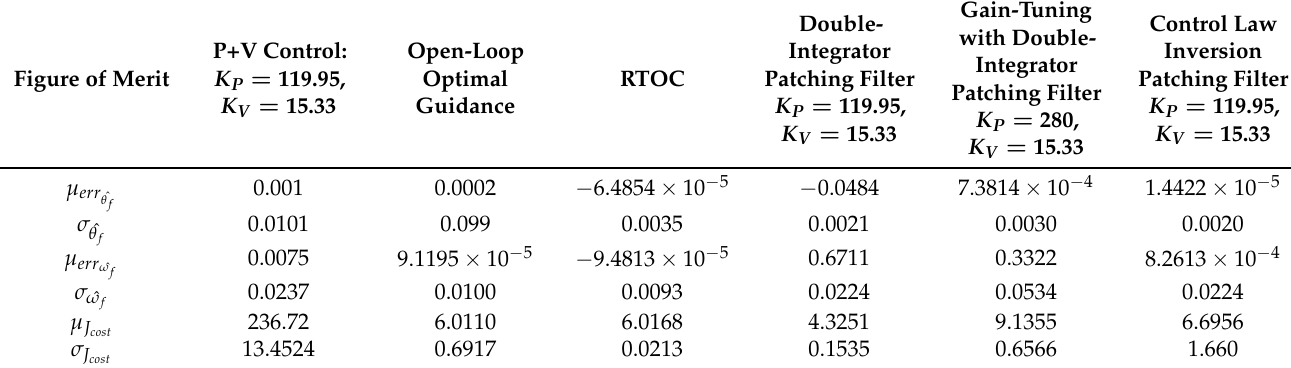
Table 3. Figures of Merit for adding uncertainty to various control schemes. Gaussian noise in ˆ θ and ˆ ω of σ = 0.01 and Uniform Distribution of I = 1 ± 0.1 ( N = 1000). ode4 (Runge–Kutta) integration with h = 0.01 s